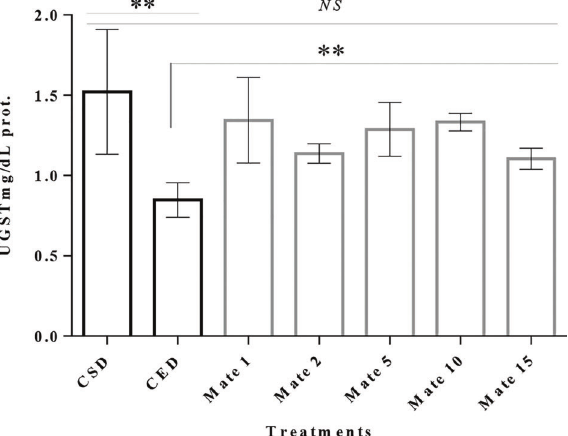
Figure 7. Glutathione S-transferases (GST) activity in the whole- body homogenate of fl ies after 10 days on various diets: control standard diet (CSD), control experimental diet (CED) and experi- mental diet + mates (Mate 1 to Mate 15). Flies were homogenized in groups of 20 males. NS: not signi fi cant. Data are reported as means ± SE. **P o 0.01, ANOVA followed by Dunnett ’ s